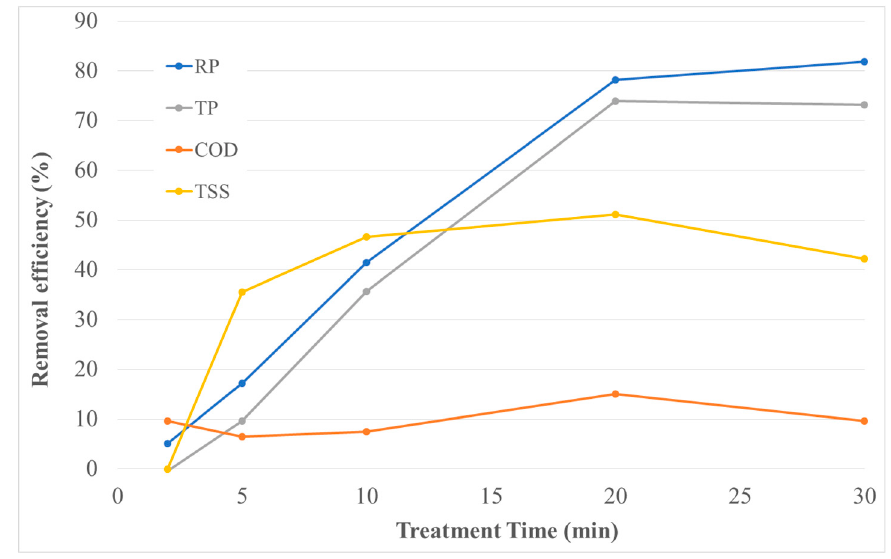
Figure 4. Effect of treatment time on RP, TP, COD and TSS removal (EC: 10 W). Figure 4. E ff ect of treatment time on RP, TP, COD and TSS removal (EC: 10